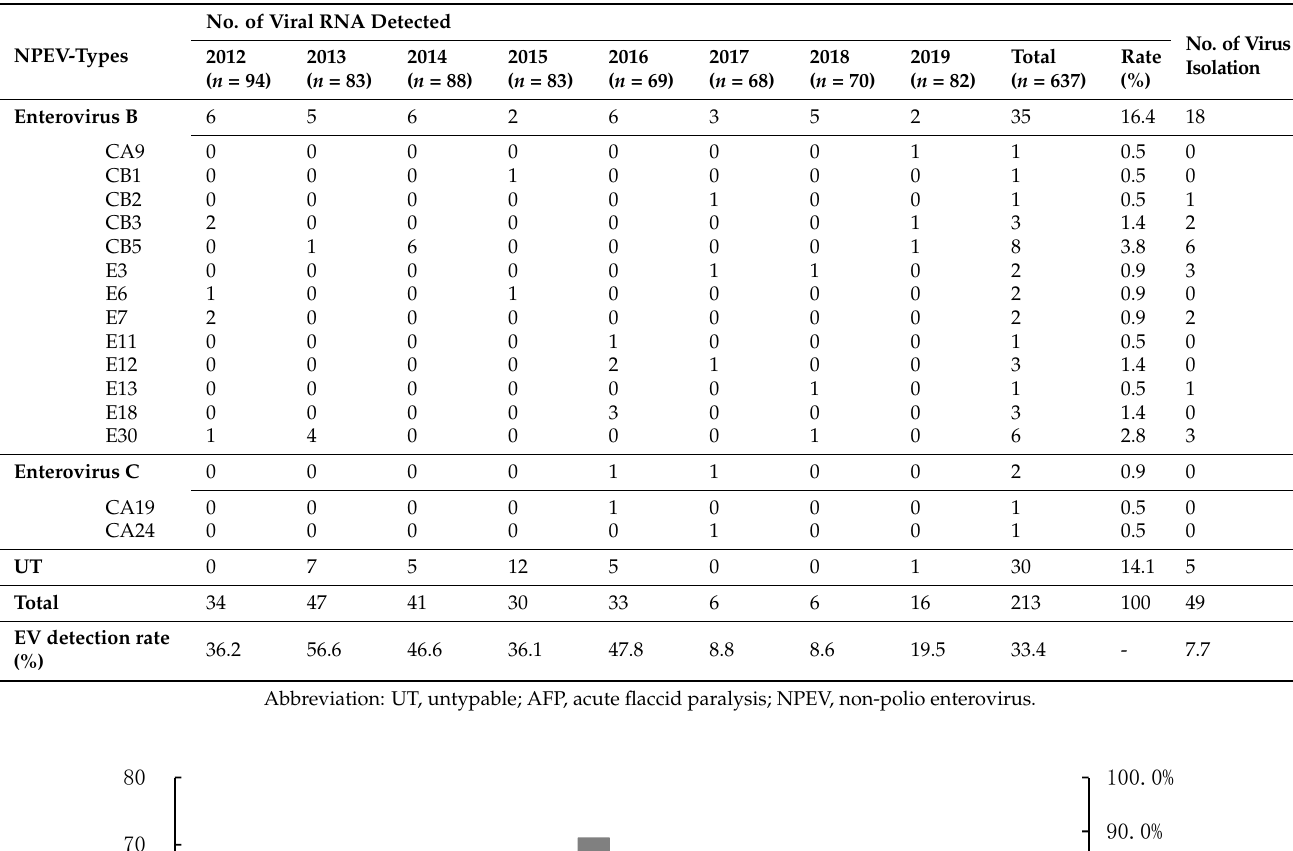
Figure 2. Clinical diagnoses of AFP surveillance system in Korea, 2012–2019. Error bars show the standard deviation of cases during 2012-2019. ADEM, acute disseminated encephalomyelitis; GBS, Guillain-Barré syndrome; HFMD, hand-foot- and-mouth disease; Other, acute respiratory diseases, myocarditis, sepsis neonatorum, etc.; AFP, acute flaccid paralysis; NPEV, non-polio enterovirus.